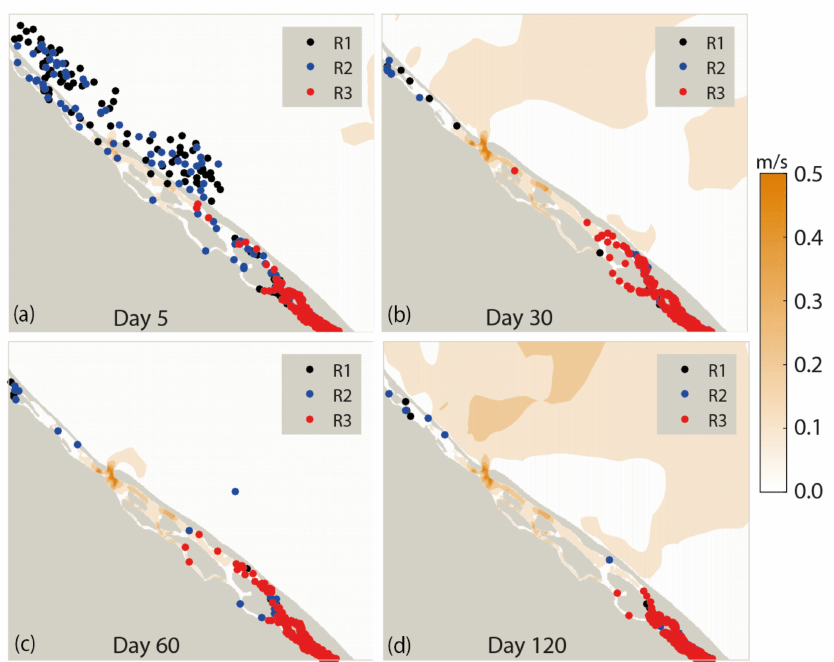
Figure 6. Spatial distributions of the current speed and trajectories for particles released at R1, R2 and R3 (please refer Figure 2 for initial release locations) on ( a ) Day 5, ( b ) Day 30, ( c ) Day 60 and ( d ) Day 120 during the northeast monsoon for old inlet configuration.